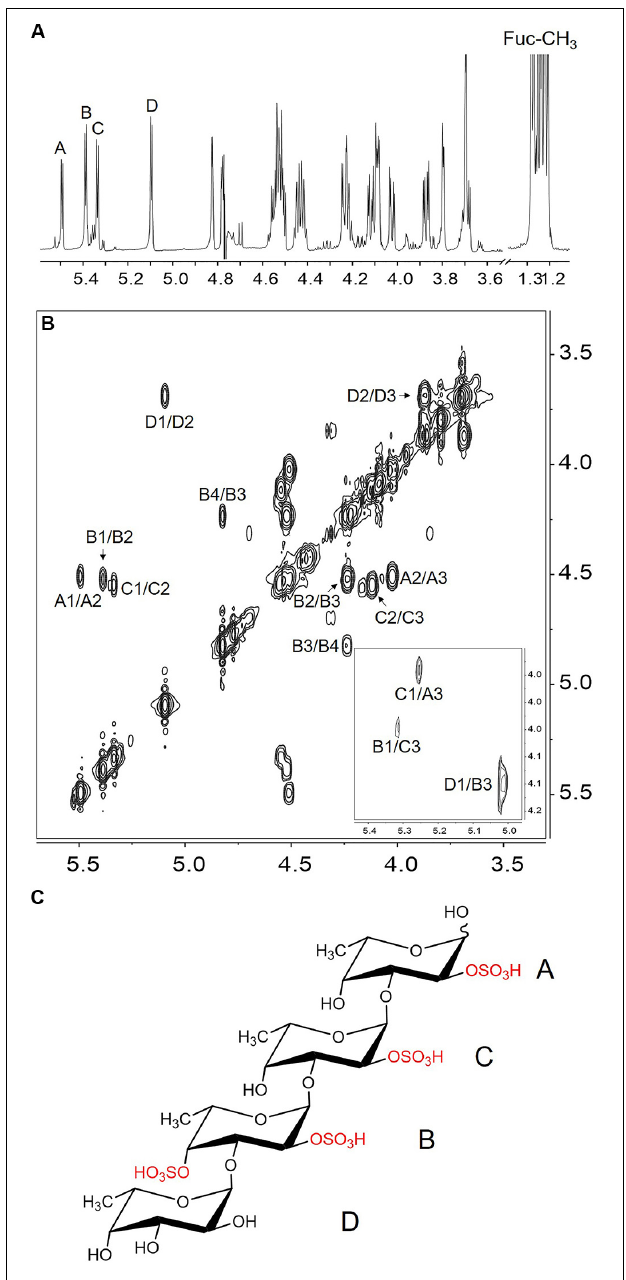
FIGURE 3 | The 1 H NMR (A) , COSY (B) , NOESY (insert of B) spectrum and the structure (C) of the major component in the end product of FunA. A1/A2 indicated the cross-peak between H-1 and H-2 of residue A,